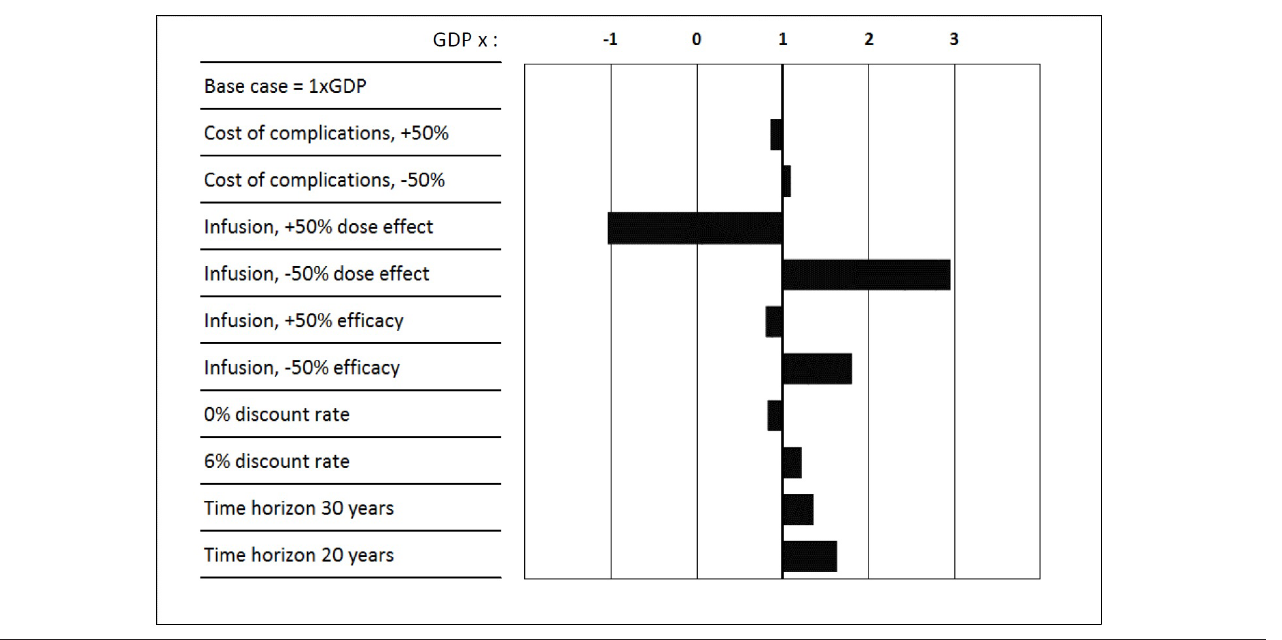
Figure 1. Sensitivity Analysis Presented as ICERs Representing Fractions of GDP per Capita, Where Results Below 1x GDP per Capita Are Highly Cost-effective and Below 3x GDP per Capita Are Cost- effective at a Daily Cost of a Simple Insulin Infusion Device of USD 13.4 per